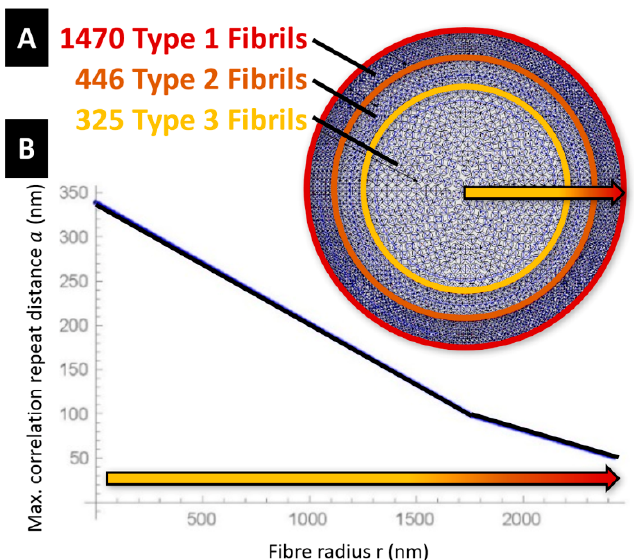
Figure 3. ( A ) Spatial distribution of the fibrils over the fibre cross-section. ( B ) Interpolation function of the microstructure parameter 𝑎′ .